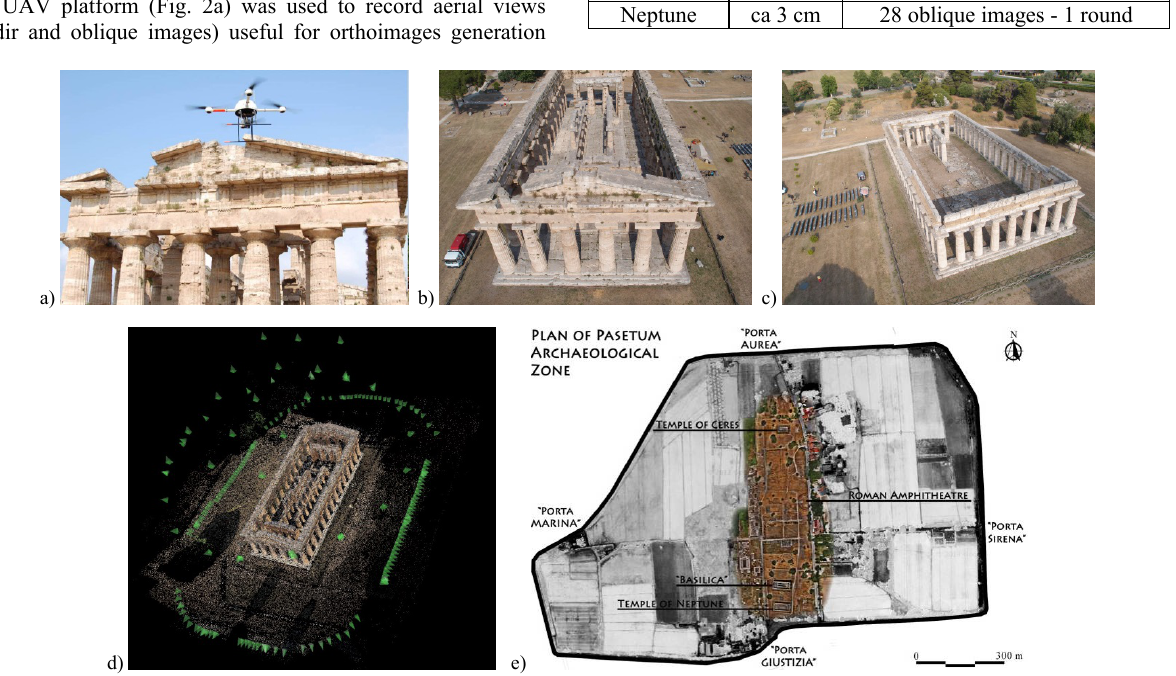
Figure 2: The employed UAV platform (a) and two oblique views of the Neptune (b) and “Basilica” (c) temples. The UAV image block over the Neptune temple integrated with the terrestrial image survey (d). The produced geo-referenced orthoimage overlaid on an old map of entire area